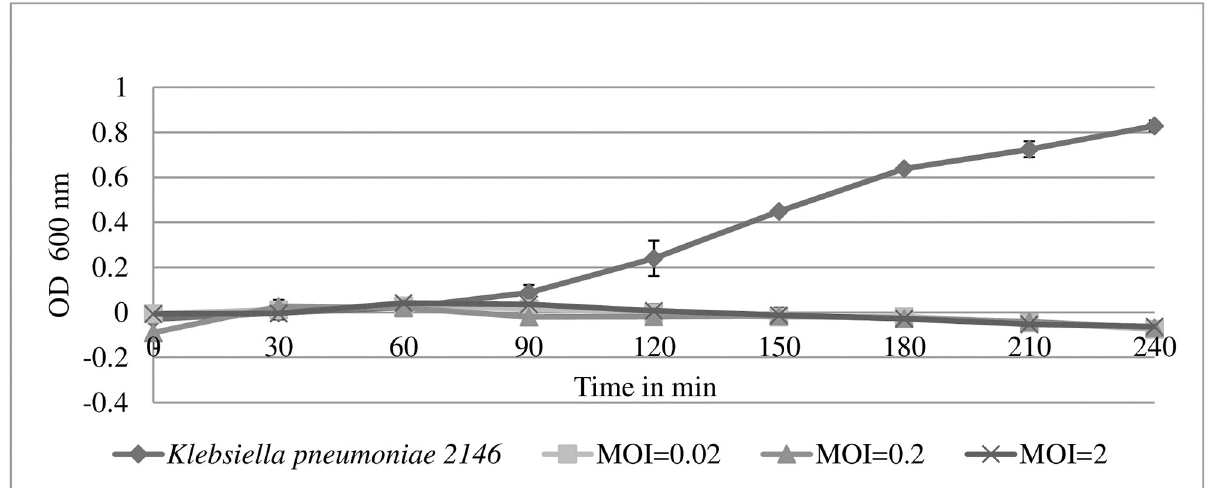
Fig 5. Turbidity assay of UPM21646 against K . pneumonia 2146. UPM2146 was able to lyse its host and clear the turbidity at 60 min for MOI of 0.02, 0.2 and 2. The bacterial count of control was 1.5 ± 0.104 × 10 9 CFU/ml at an OD 600nm of 0.8. The experiment was done in triplicates.